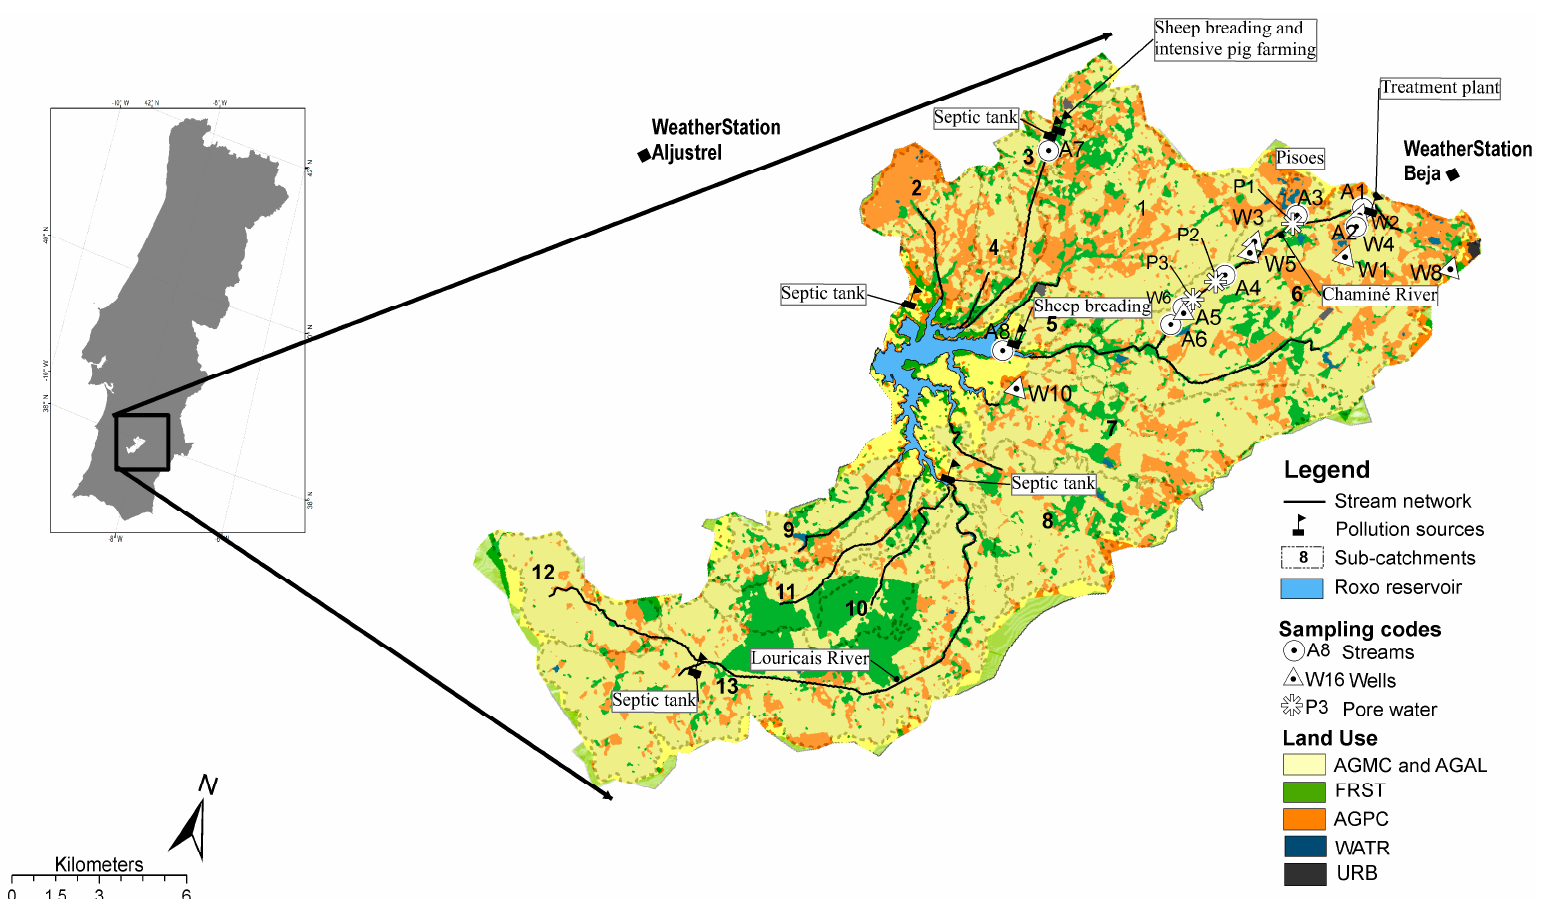
Figure 1. Location of the Roxo catchment study area, Southern Portugal, with the principal pollution sources. Circles are the sampling sites, including stream water (A), shallow groundwater (W), and pore water samples (P). A1–A9 are the stream sampling sites.